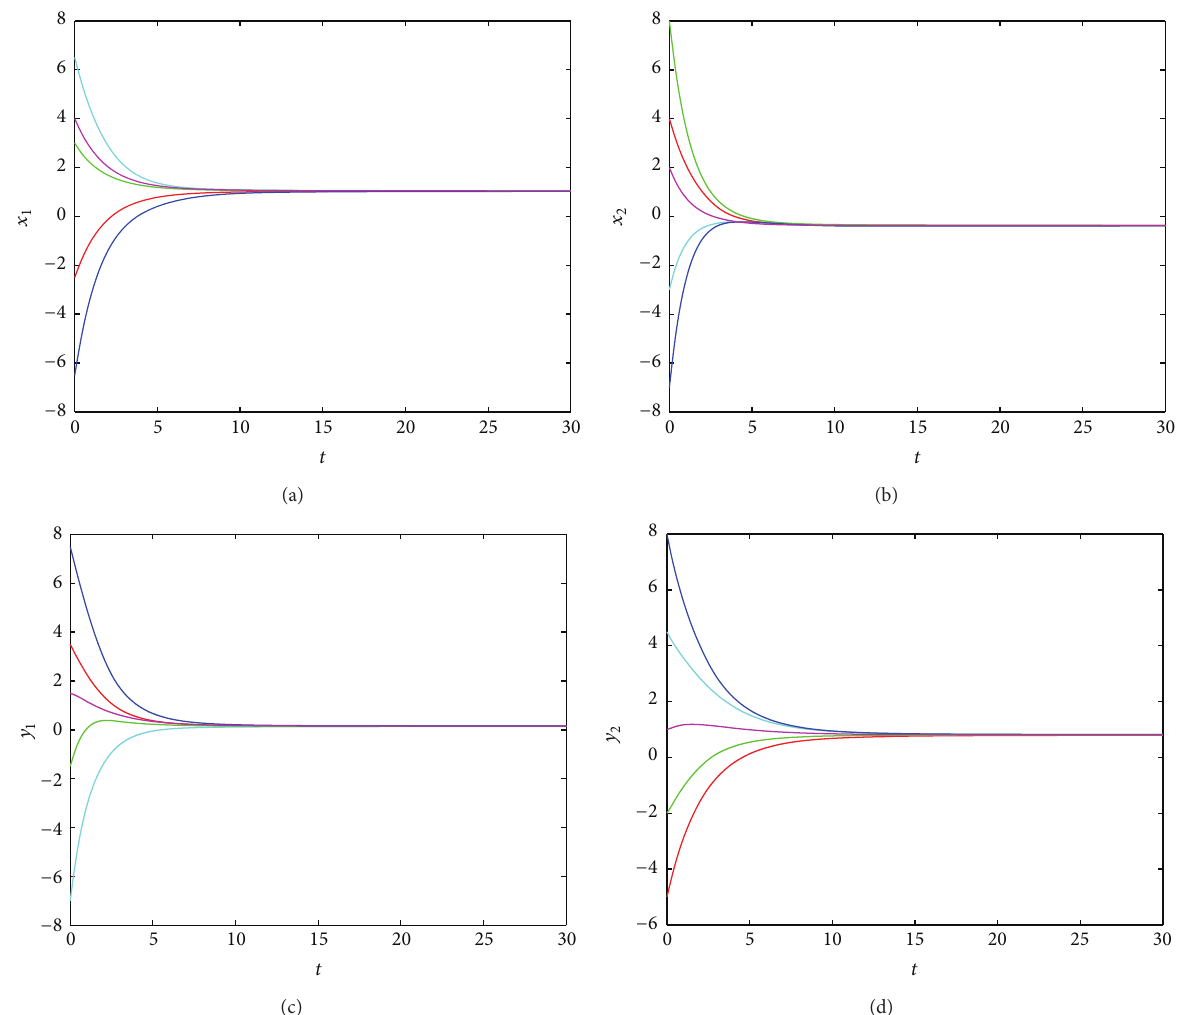
Figure 3: Transient states of the fractional-order BAM neural networks in Example 2 with 𝛼 = 0.98 , 𝜎 = 0.20 , and 𝜏 = 0.40 .